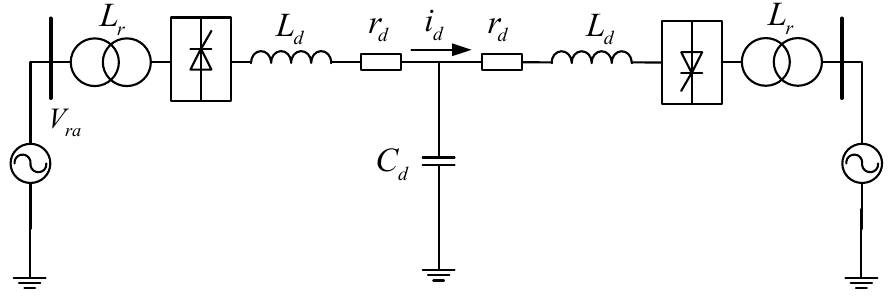
Figure 10. Single bridge six pulse HVDC system.